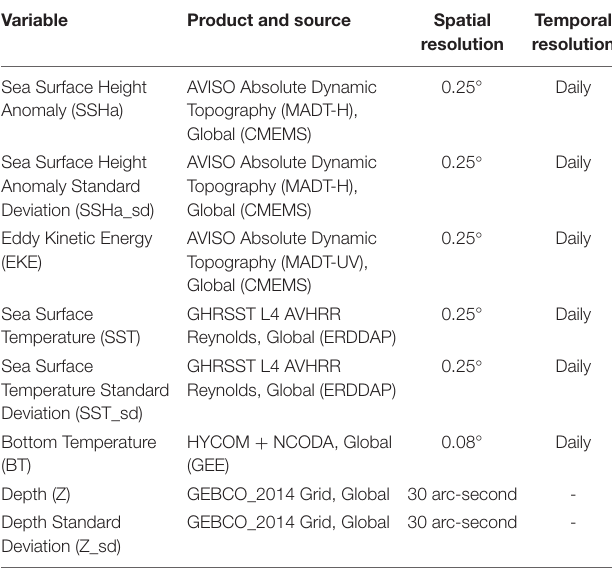
TABLE 2 | List of environmental variables used, the specific product and source, as well as spatial and temporal resolution. Variable Product and